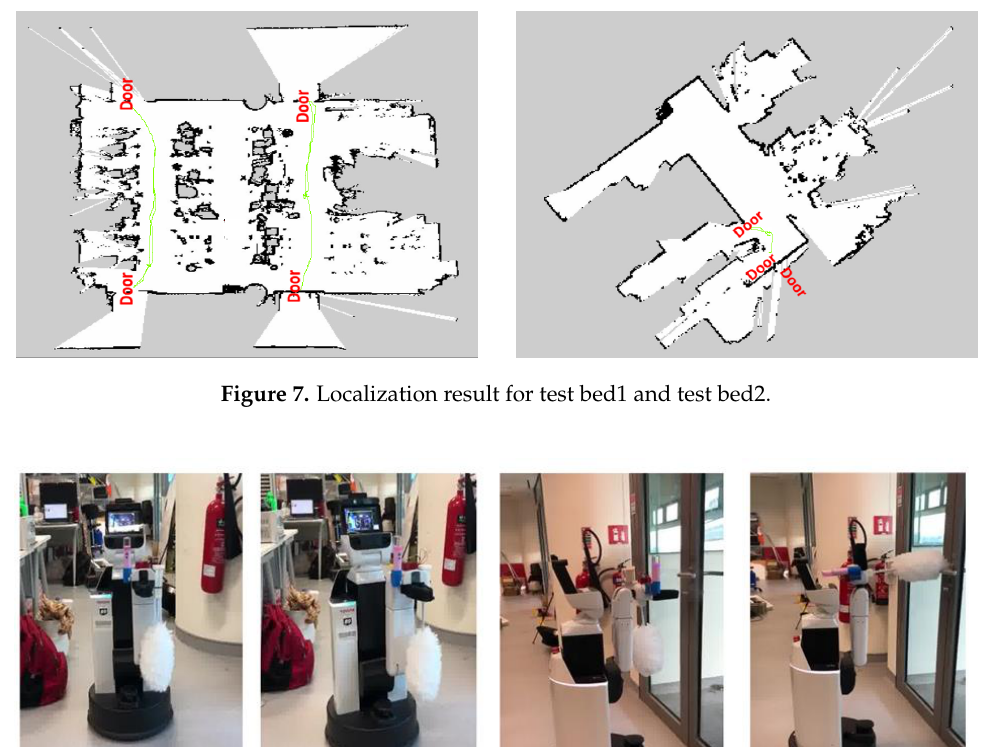
Figure 6. offline test results